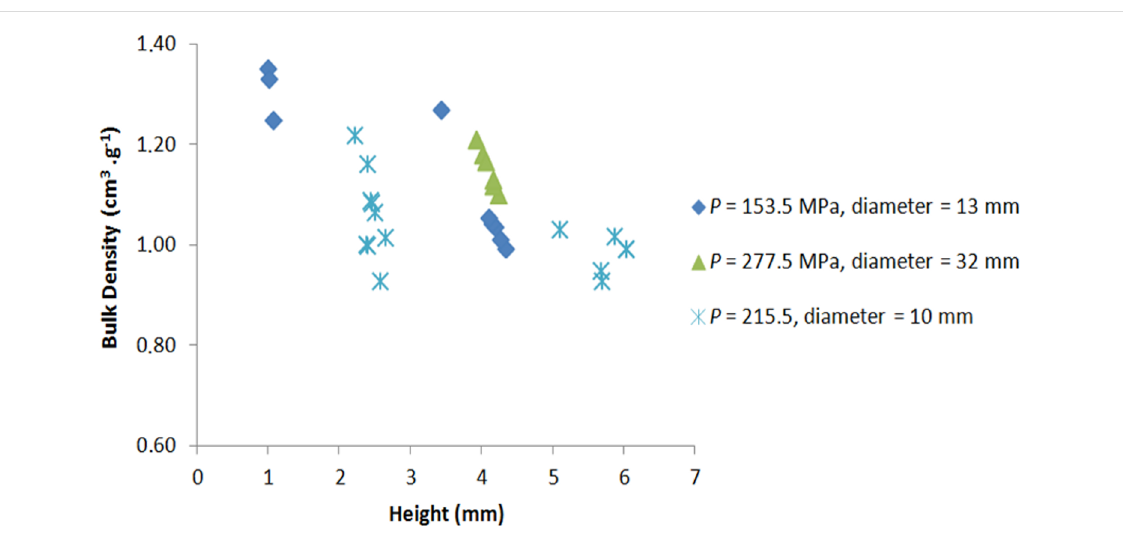
correlation between samples size (diameter and height) and me- chanical properties makes physical sense. Indeed, when the applied pressure (compression load) increases, the bulk density of the pellet increases. For example, the pellet height decreases from 3.2 to 2.8 mm when the applied pressure increases from 75 to 600 MPa with the same mass of zeolite (0.4 g, diameter = 13 mm). This behavior is linear up to 400 MPa (studied range) and after 400 MPa the density of the pellet levels off (1050 kg·m − 3 ). This can be explained by a density gradient along the pellet height. The thicker the pellet, the higher the density gradient is in the material